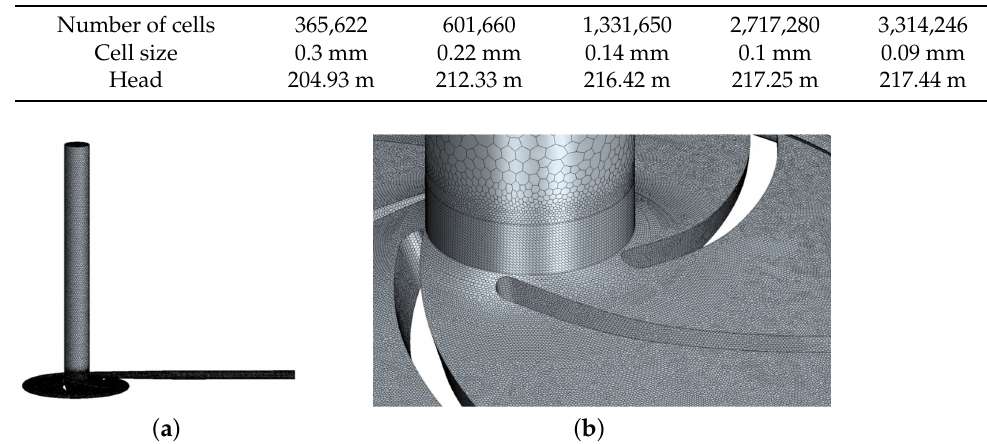
Table 2. Grid dependency results.